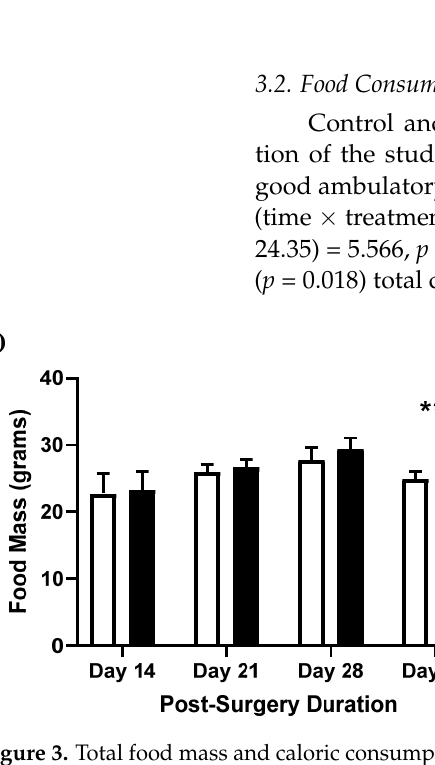
Figure 2. Body weight in C57BL/6J male and female mice following orthotopic LL/2 non-small lung cancer cell implantation. ( A ) Body mass (grams) between control and treatment mice. ( B ) Body mass fold change between control and metformin- (250 mg/kg) treated mice following orthotopic LL/2 cancer cell implantation. Data were analyzed using mixed modeling (time × treatment). *** p < 0.001, main effect for time. Control, n = 7; metformin, n = 9. Data shown as mean ± SEM.